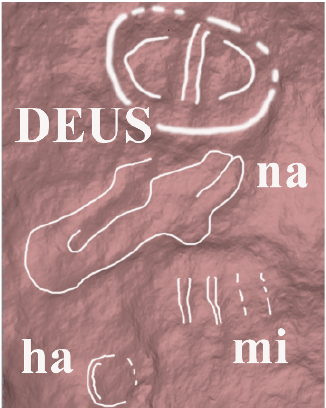
Figure 12. Detail of the hieroglyphic inscription related to the deity 17